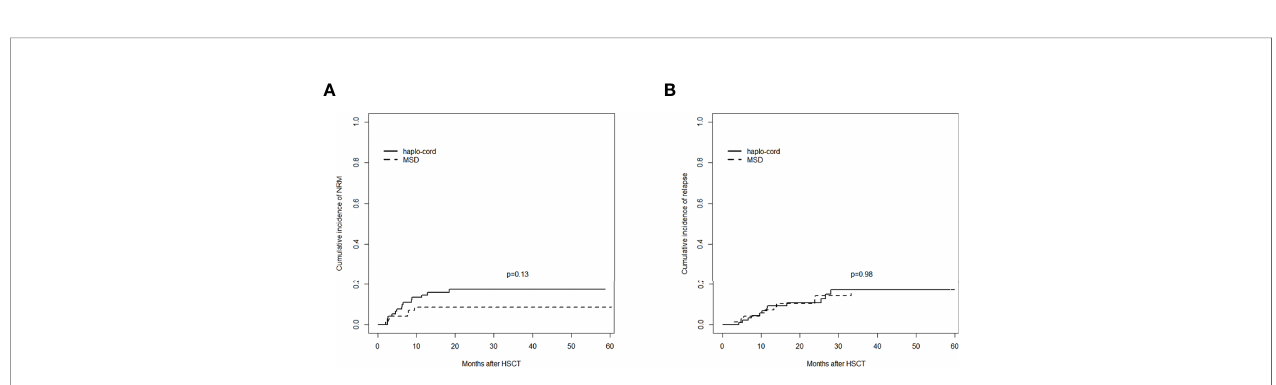
FIGURE 3 | Assessment of cumulative incidence of cGVHD in haplo-cord group and MSD group: (A) all grades of cGVHD and (B) cGVHD (moderate/severe). cGVHD, chronic graft-versus-host disease; MSD, matched sibling donor.